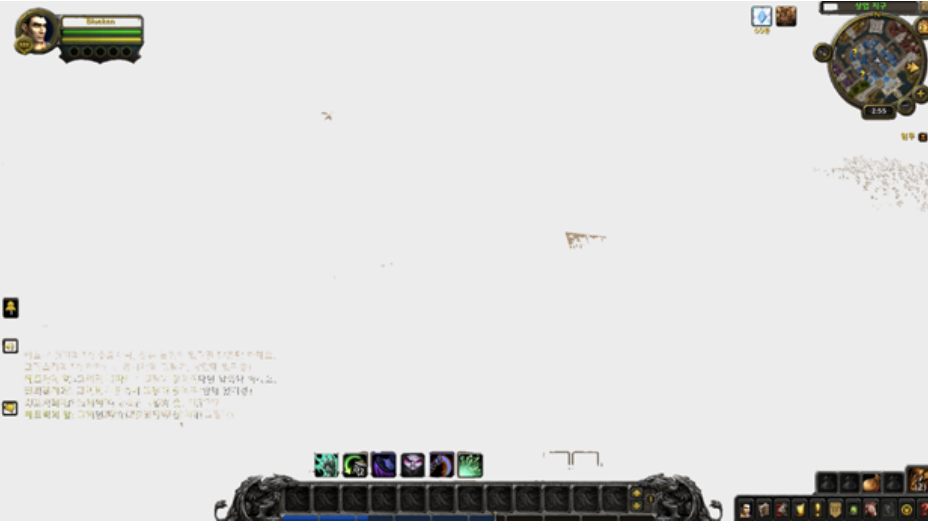
Figure 5. Images of cases where auto labeling does not work